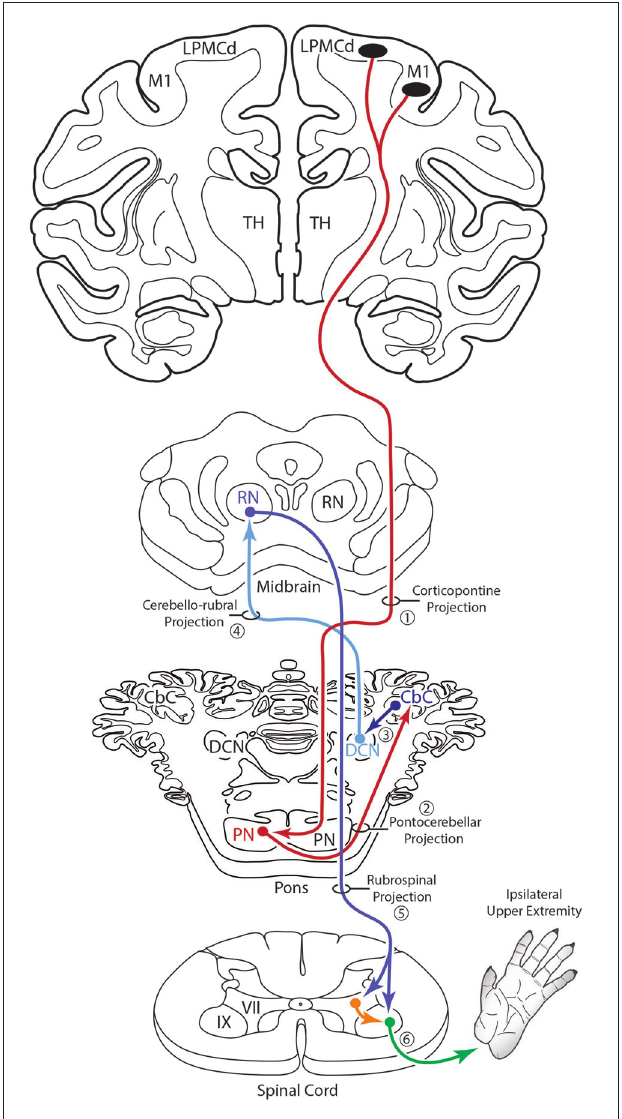
FIGURE 11 | Summary diagram illustrating a potential contribution of the cCPP on the subcortical cerebellar circuit influencing the red nucleus which in turn projects to the contralateral spinal cord. The organization of the subcortical circuit positioned downstream on the cCPP is based upon the circuit characteristics of the classic cerebello-rubral (dentato-rubral) projection